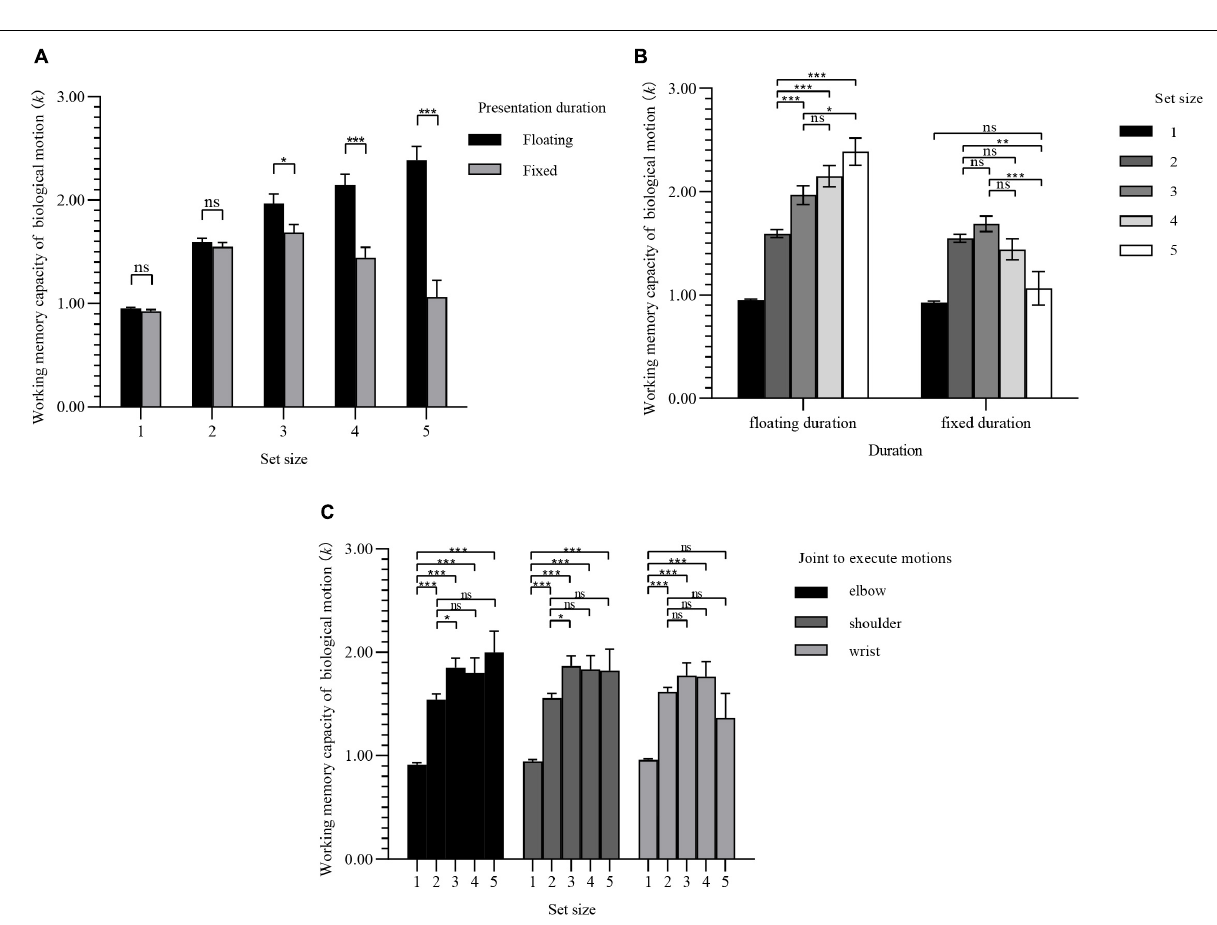
FIGURE 4 | Simple effect results of experiment 1. Values are reported as mean ± standard error. The Bonferroni method was used for multiple test correction. (A) Comparison of BM WMC for presentation durations under different set sizes. (B) Comparison of BM WMC for set sizes under different presentation durations. (C) Comparison of BM WMC for set sizes under different joints to execute motions. ns: not significant; * p < 0.05; ** p < 0.01; ** *p <